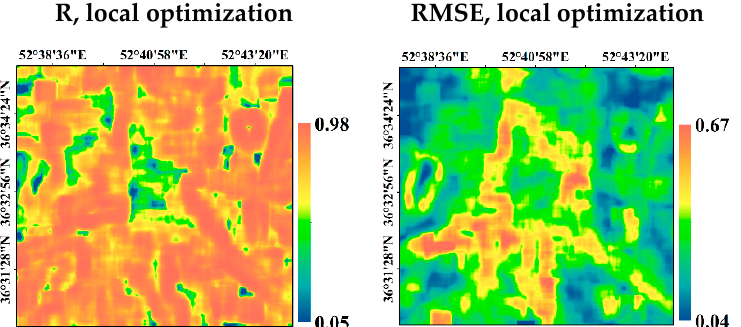
Figure 12. Modeled LST variations based on NDBI, greenness, and wetness variations using multivariate OLS regression with regional and local optimizations (°C).